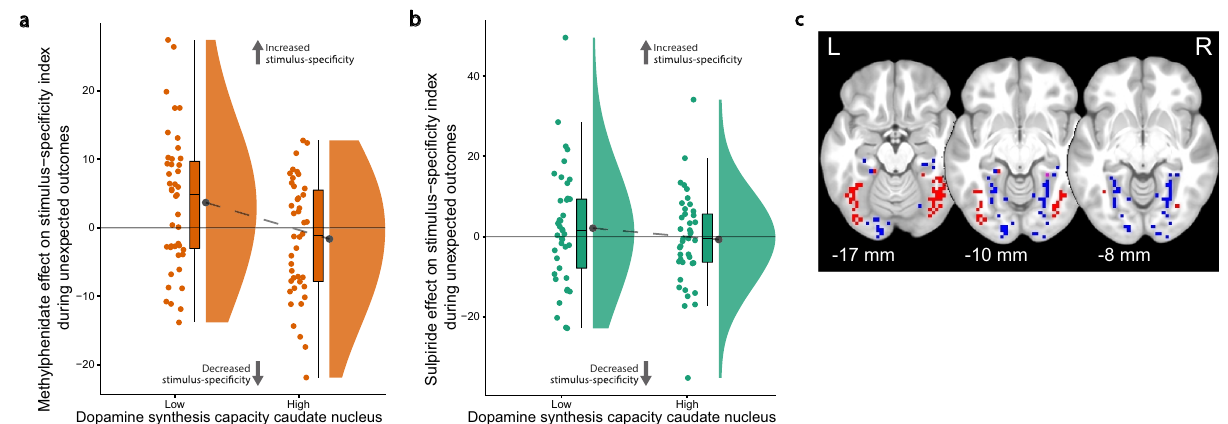
Fig. 3 | Effects of methylphenidate and sulpiride (relative to placebo) on sti- mulus speci fi city of BOLD signal in the fusiform face area (FFA) and para- hippocampal place area (PPA) during unexpected outcomes. Effect of methylphenidate ( a ; N =85 participants) and sulpiride ( b ; N =82) on stimulus- speci fi c reversal-related signal in FFA/PPA as a function of low and high caudate nucleus k i cer (median split for visualization; methylphenidate versus placebo×